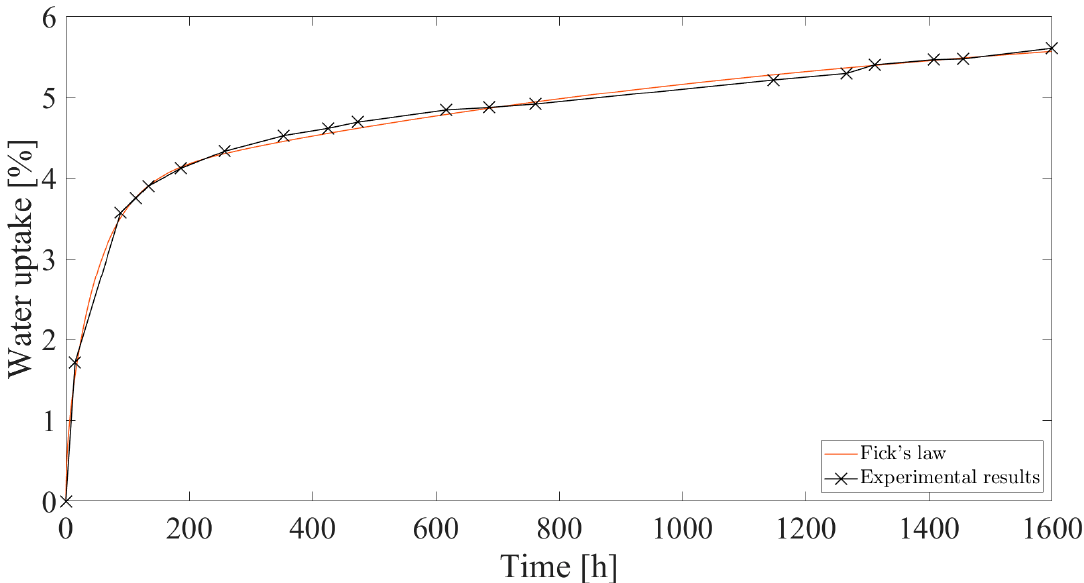
Figure 10. Dual-Fickian numerical model curve and experimental results for the gravimetric analy- sis in water. in water.